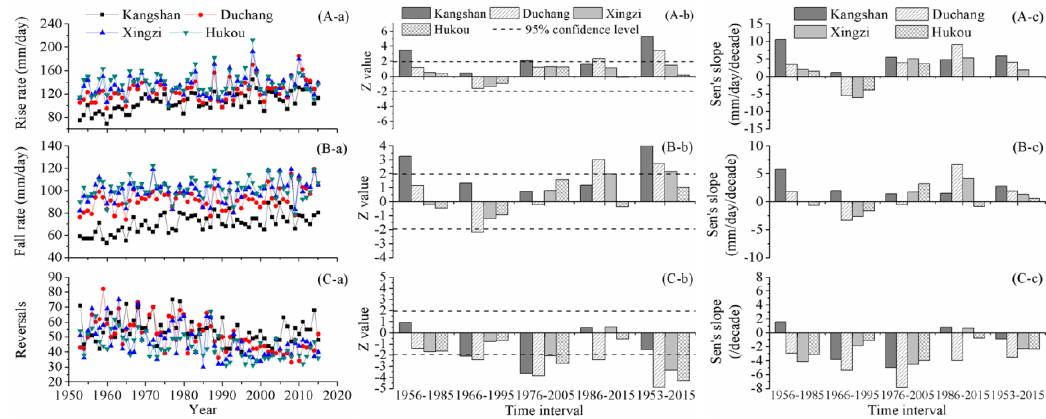
Figure 7. Variation features of fluctuating rates and reversals of water level in Poyang Lake: (i) the sub-figures labeled (A–C) display change features of rise rate, fall rate, and reversals, respectively; and (ii) the sub-figures labeled (a–c) display annual values, Z values, and Sen’s slopes, respectively.